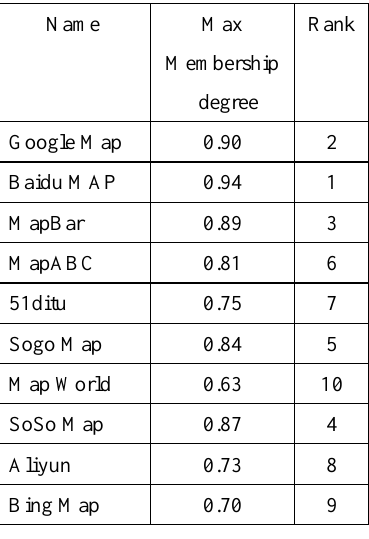
Table 3. Evaluation